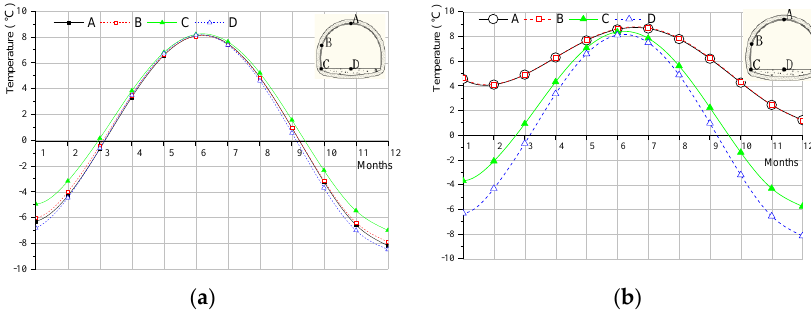
Figure 12. Monthly average temperature curves at different locations on the surface of secondary lining and lane plate: ( a ) without heat-insulating layer and ( b ) with heat-insulating layer (cross-section K0 + 015).